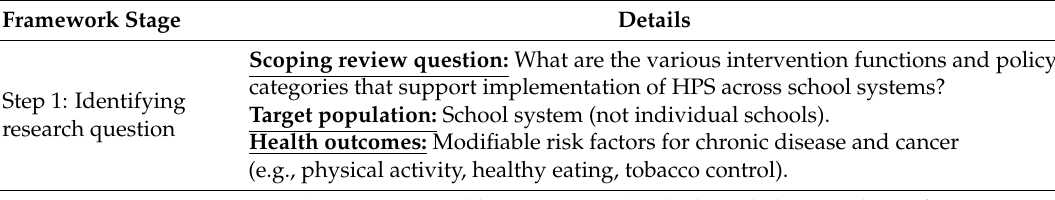
Table 2. Scoping review framework stage